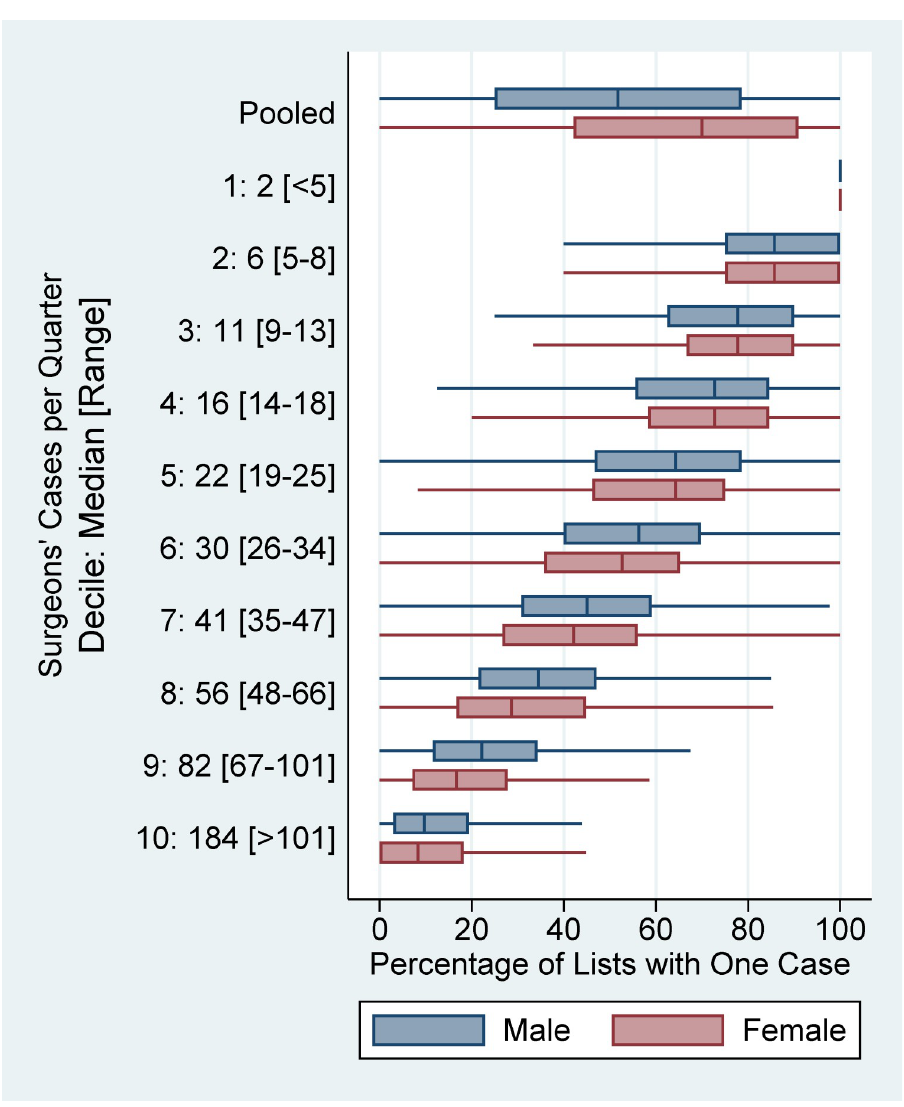
Fig 1. Proportions of surgeon-date-facility combinations (i.e., lists) per quarter with one case, plotted by surgeon gender (colors) and by deciles among surgeons in their cases per quarter (rows). The pooled rows include all surgeon-quarter combinations with at least one case. Those pooled rows show the findings of Hypothesis 1. While 44.2% of male surgeons’ lists of cases had one case, 54.6% of female surgeons’ lists had one case, significantly more (P < .0001). The next 10 rows show the findings of Hypothesis 2. With adjustment for quarterly operative caseloads, the gender association (male < surgeon) is mitigated fully, because male surgeons’ mode was the 10 th decile while female surgeons’ mode was the 2 nd decile (i.e., they performed fewer cases). Put another way, select at random a male surgeon-quarter and a female surgeon-quarter, both in the same decile of quarterly caseload. The paired